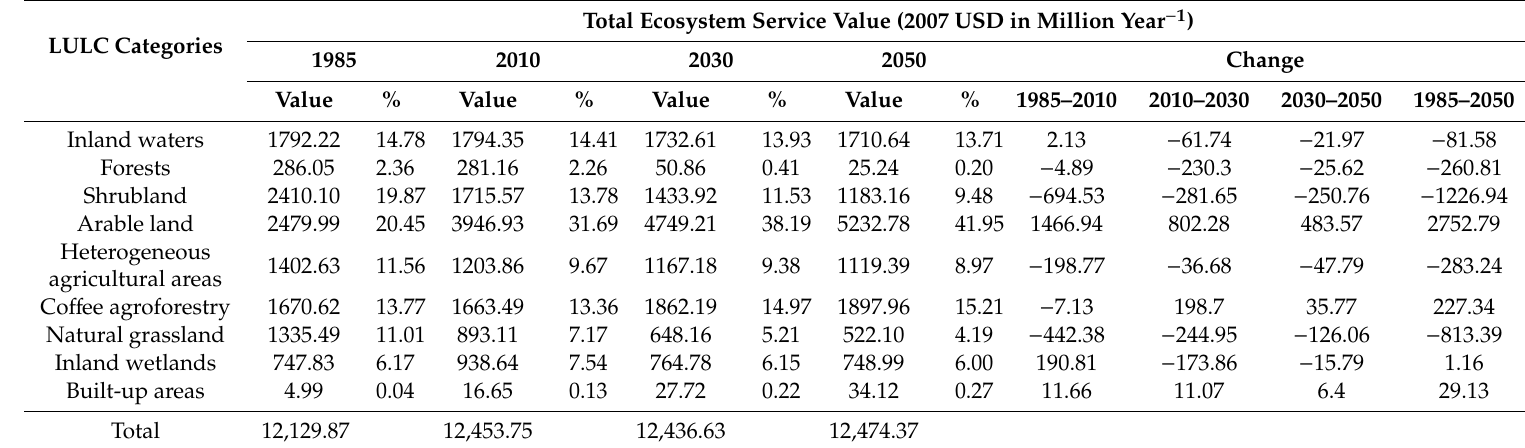
Table 4. E ff ect of LULC change on the total value of ecosystem services of ACB from 1985–2050 based on Costanza et al.’s [12] global unit value coe ffi cient. LULC